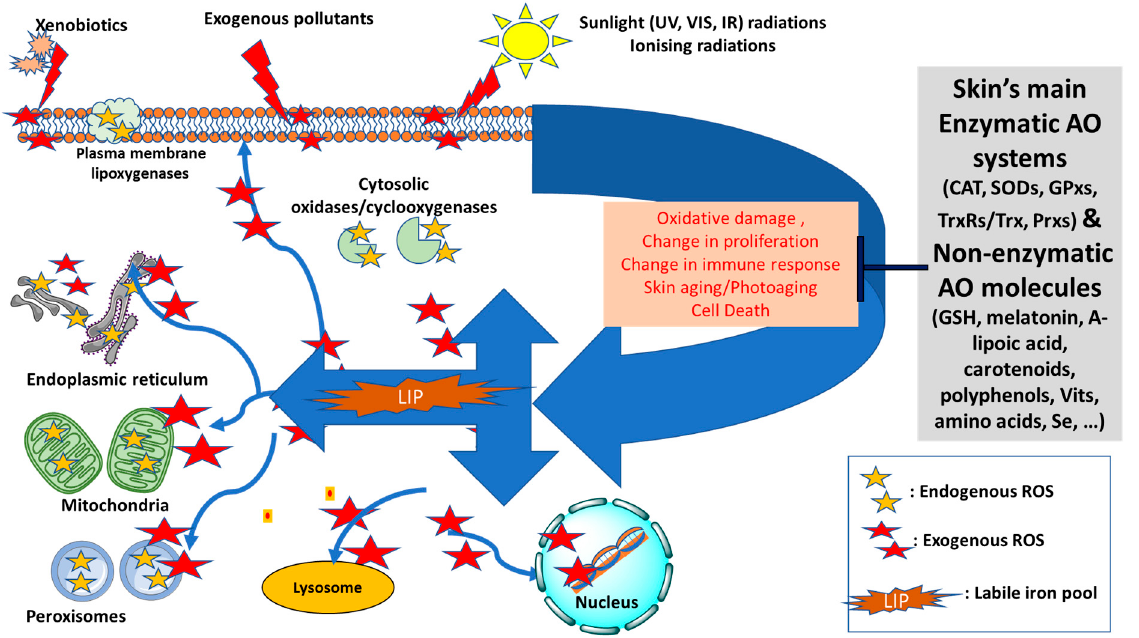
Figure 1. Diagram of the redox balance in the skin — Endogenous sources of reactive oxygen species (ROS, shown as yellow stars) can be generated intracellularly in mitochondria, peroxisomes, plasma membrane (lipoxygenases) or cytosolic enzymatic systems (oxidases and cyclooxygenases). The skin’s antioxidant (AO) defense will maintain the redox homeostasis by neutralising the excess ROS that are likely to form by exogenous factors, notably sunlight radiations, xenobiotics or pollution. The increase in the level of intracellular labile iron pool (LIP) disrupts the iron homeostasis and intensifies the oxidative damage to cell components due to formation of highly reactive oxygenated species via Fenton Chemistry (shown as red stars). As a result, the AO defense system can be overwhelmed and redox homeostasis disrupted leading to significant oxidative cell damage, change in cell proliferation and immune response, acceleration of aging processes and even cell death (Adapted and modified from references [4–6]). UV: ultraviolet; VIS: visible; IR: infrared; CAT: catalase; SODs: